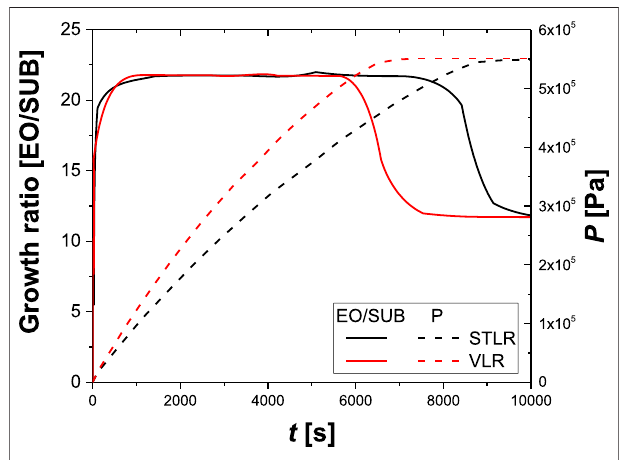
FIGURE 5| Calculated values ofgrowth ratio and total pressure, in VLR, STLR operating in the same conditions. Reactor volume: 20 m 3 ; total recirculating fl ow: 210 m 3 /h; maximum operating pressure: 5.5 bar; initial Nitrogen pressure: 1.2 bar; starter (dodecanol):500 kg; catalyst (KOH): 8 kg; exiting heat exchanger temperature: 178 ° C; fi nal growth ratio:20.5.